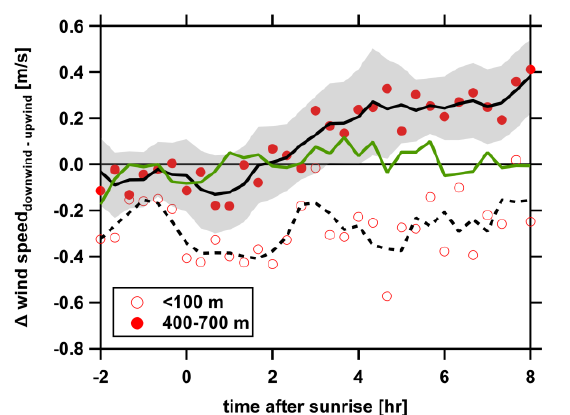
Figure 2: Mean difference in horizontal wind speed inside the UCL (red open circles), and inside the UBL (red closed circles) for wind direction = 180-269° (N = 41). The black dashed and solid lines are hourly averaged (3 points) running mean to the red open and closed circles respectively and included for visual aid. The grey shading represents the standard error of the mean. The green line is same as the black solid line for wind direction = 90-179° (N = 16).